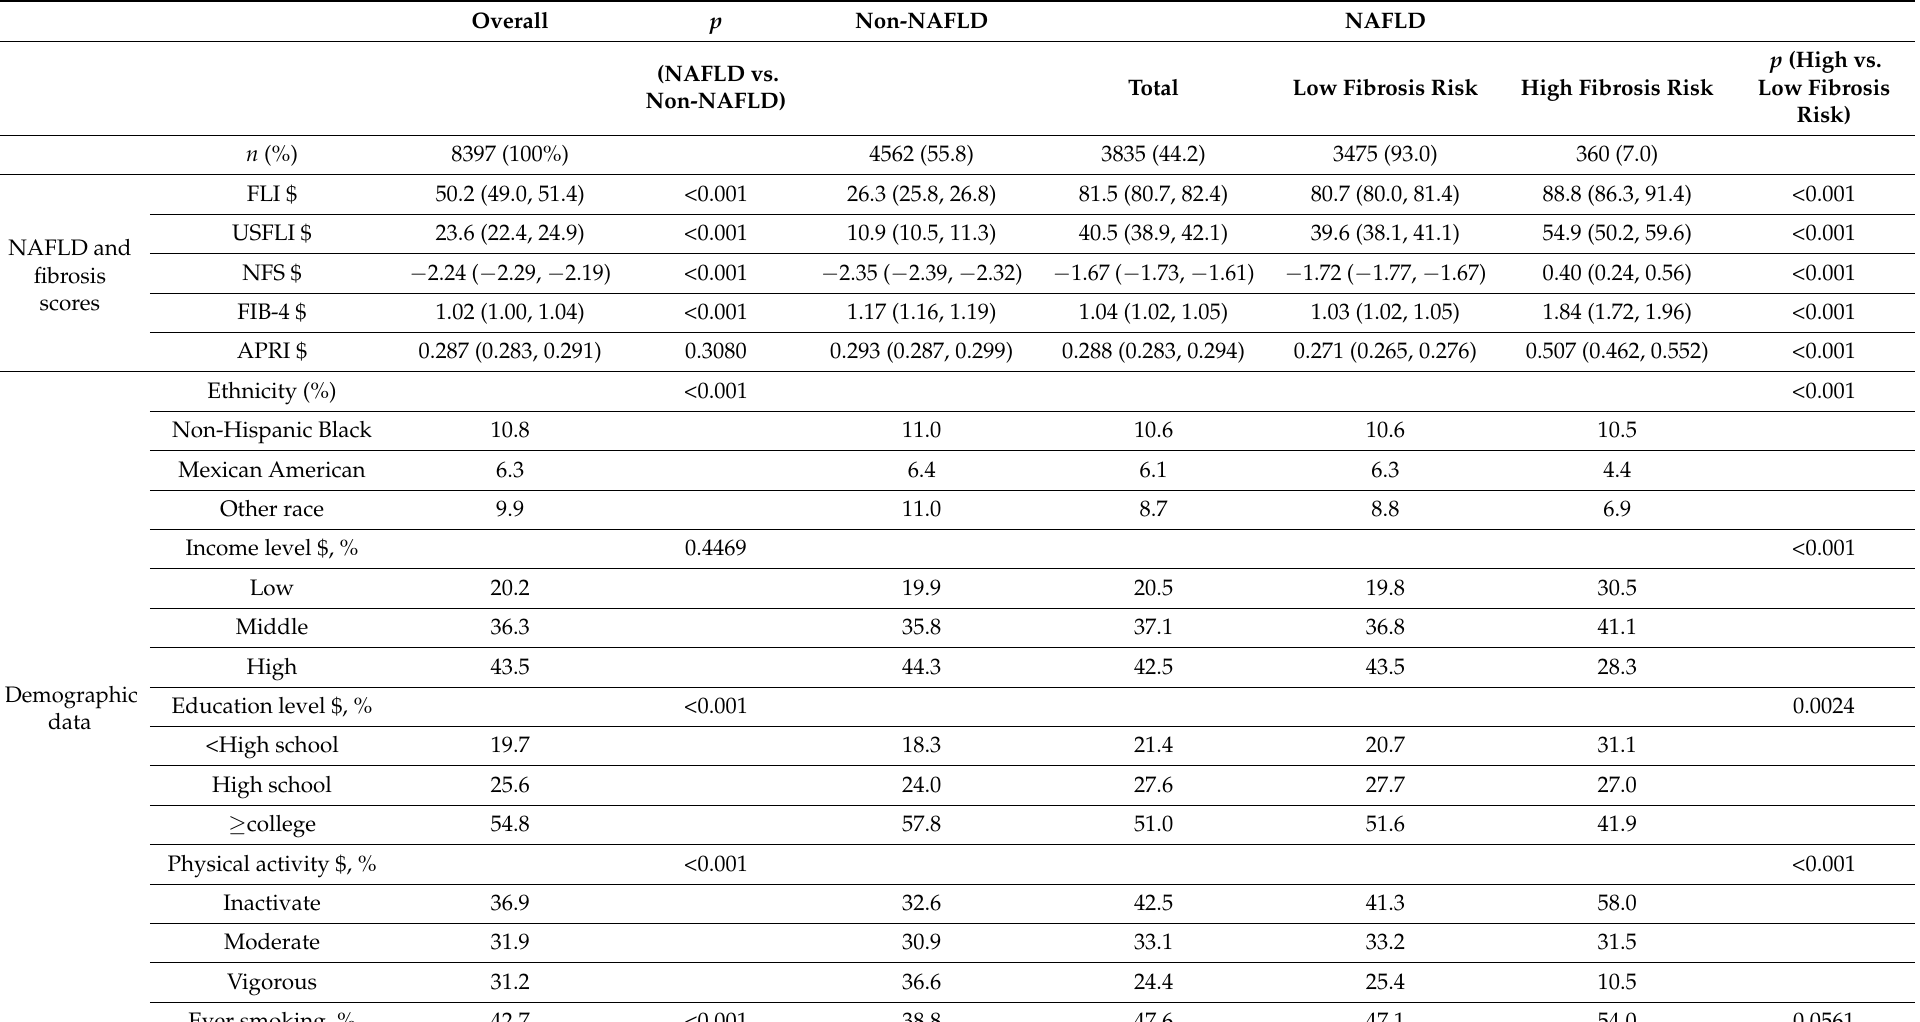
Table 1. Baseline characteristics of participants in NHANES